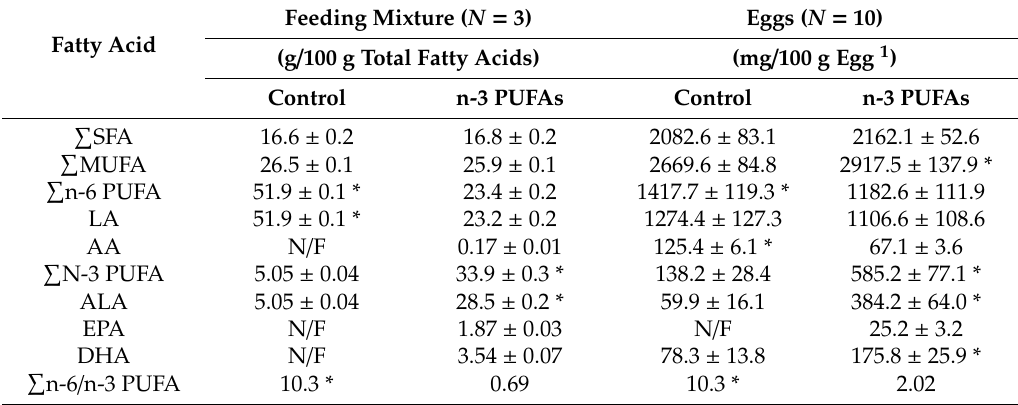
Table 2. Fatty acids profile of hens feeding mixture and edible parts of eggs.